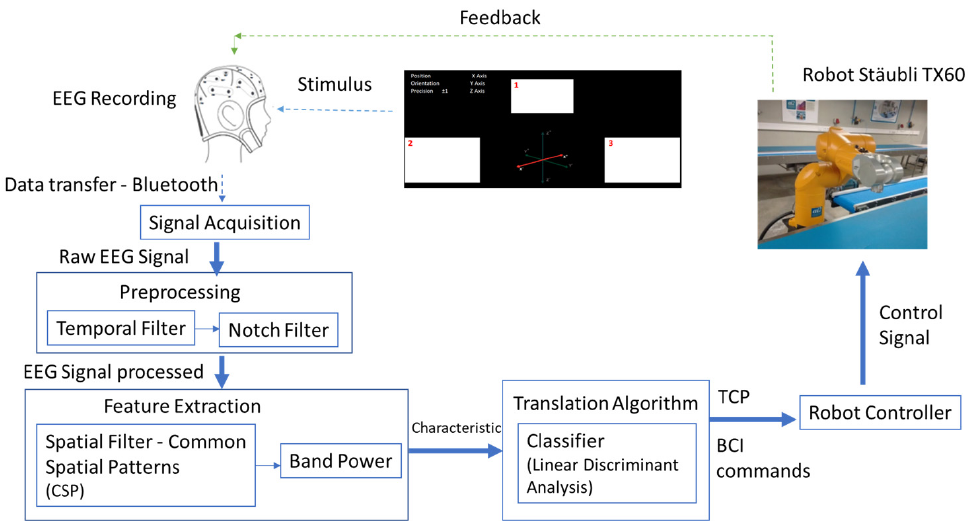
Figure 2. SSVEP-BCI methodology for robotic arm control.